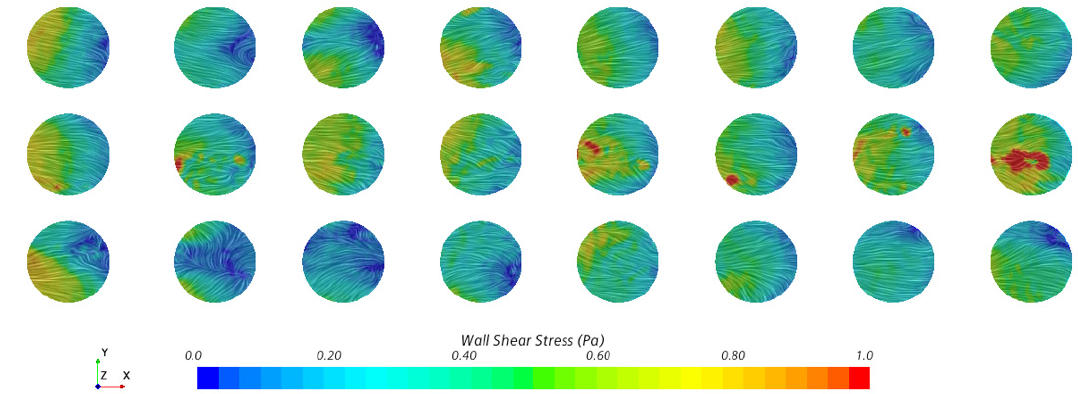
Figure 5. The wall shear stress on all 24 coupon surfaces at 25 s. Every fourth column is opposite each other in the reactor, and the baffle moves from left to right across the coupon surfaces. Table 1. Row averages of the average, maximum, and minimum total shear stresses for revolutions 20–70.